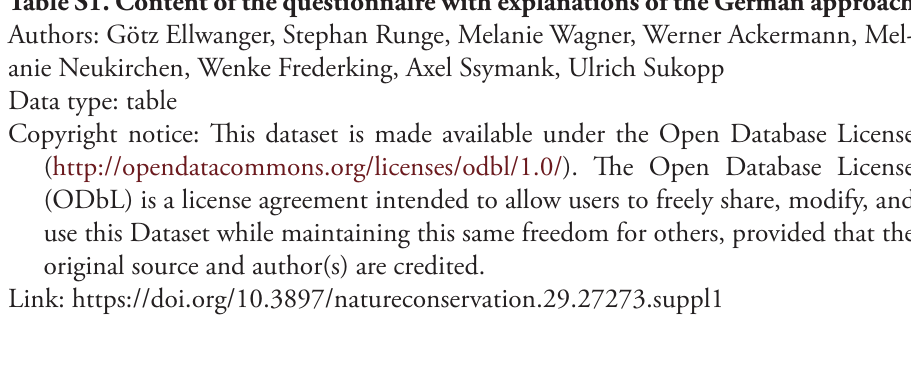
Table S1. Content of the questionnaire with explanations of the German